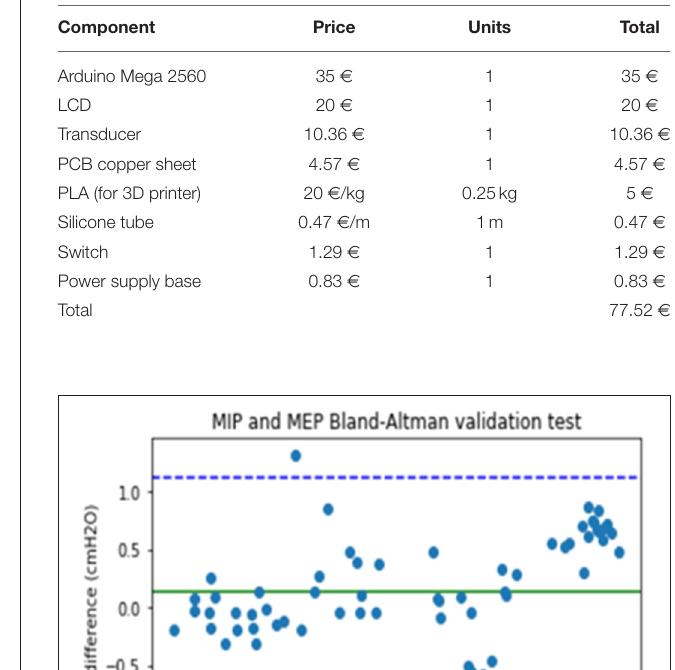
TABLE 1 | Retail cost of components used in the device.